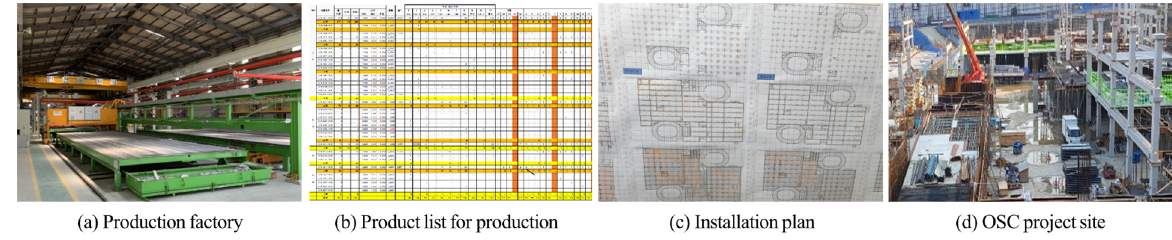
Figure 1. Site visit and data collection.